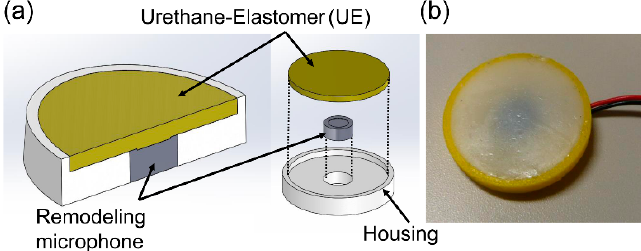
Figure 1. ( a ) Structure and ( b ) actual photograph of a BCS.